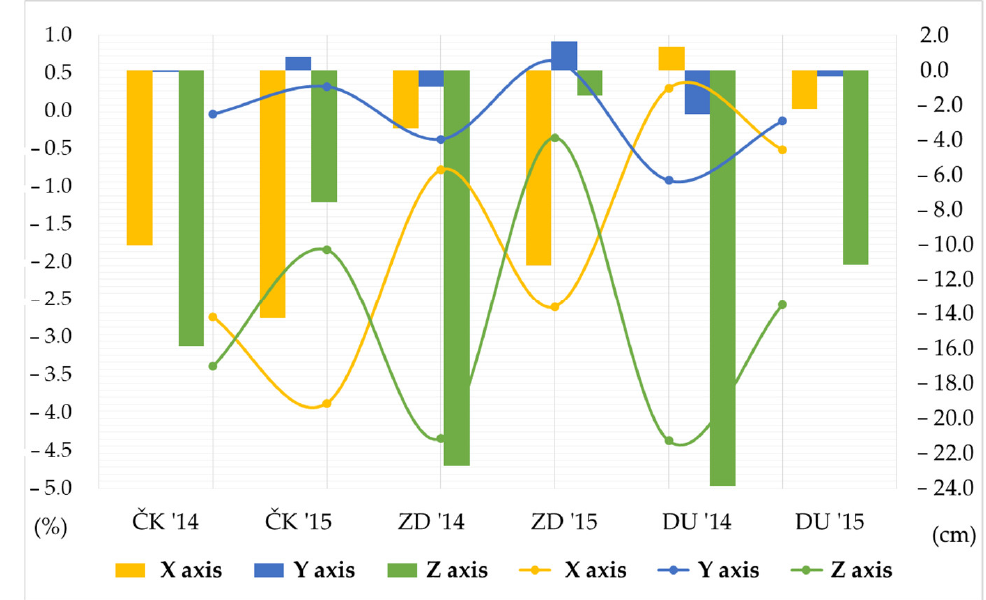
Figure 3. Movement of RMSE deviation values using the proposed model from the exact geodetic position of the observed locations expressed in absolute (right y -axis) and relative (left y -axis) val- ues.